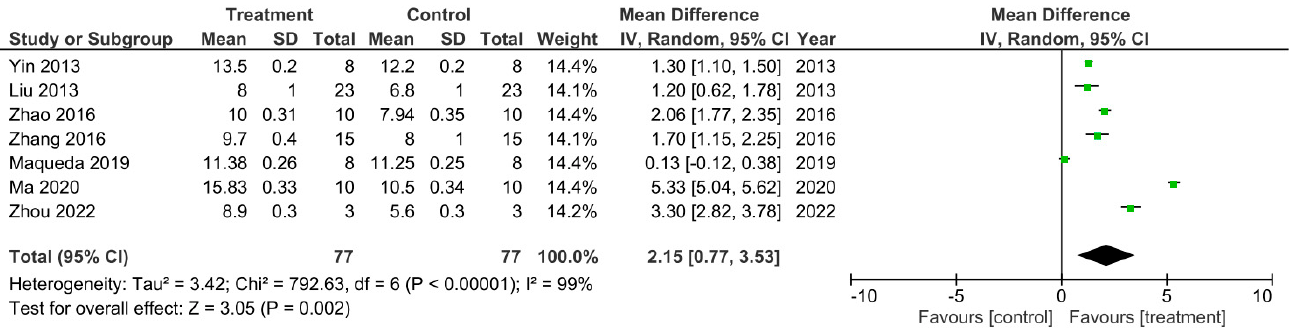
Figure 5. A meta-analysis for the effect of single treatments on the improvement of BBB scores analyzed at 56 days after spinal cord injury in seven studies [15,18,26,29,40,47,50].